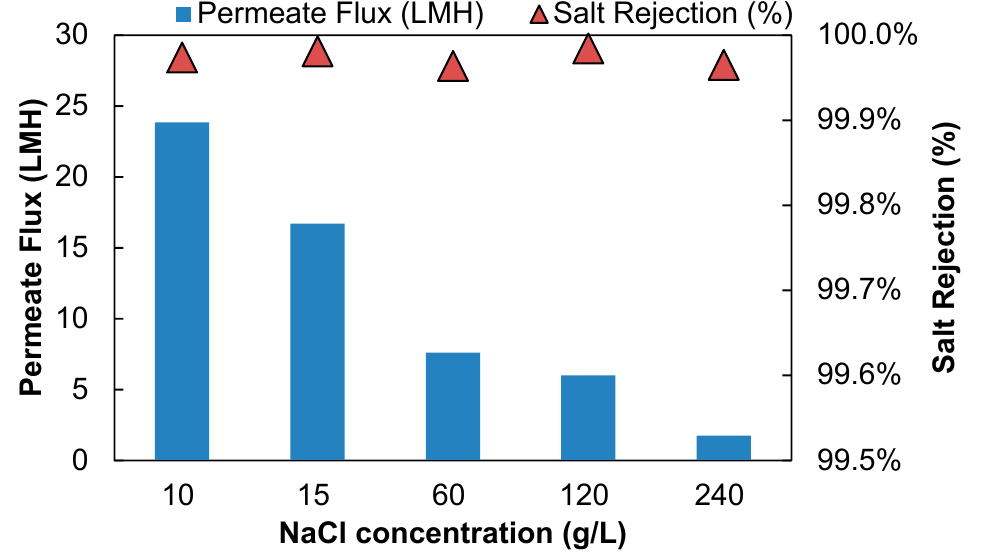
Figure 5. The impact of feed concentration on PVD system performance at 85 ◦ C with crossflow Reynolds number of 4800 and permeate vacuum of 0.85 bar. The blue bars represent permeate flux ( y -axis on the left) and the red triangle dots represent salt rejection ( y -axis on the right). Table 2. Simulation results of parameters values with di ff erent NaCl concentration. NaCl Concentration (g /